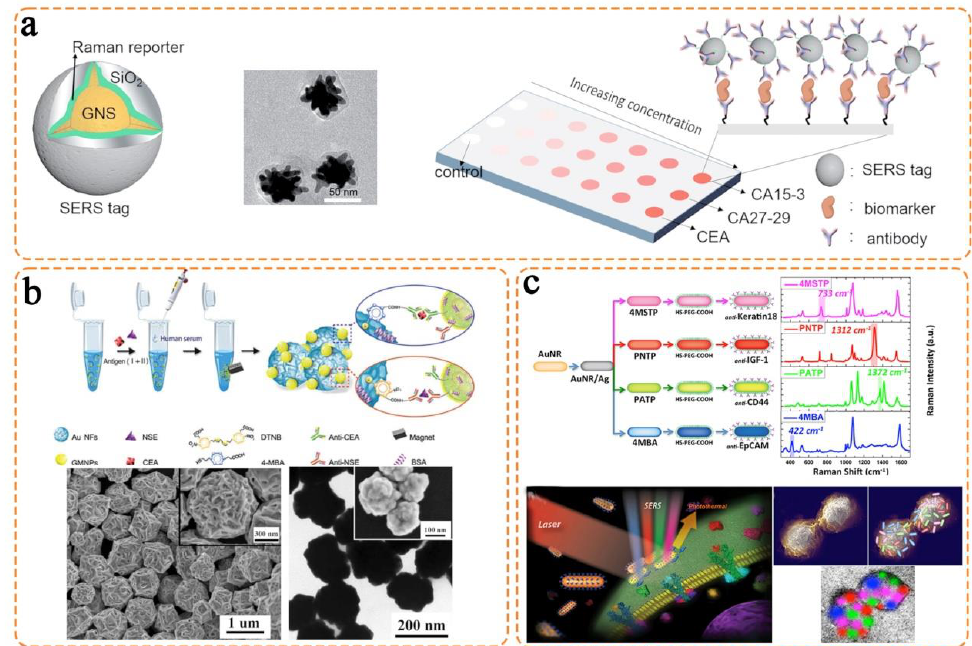
Figure 6. Anisotropic nanostructure-based SERS nanotags for parallel detection of multiple circulating biomarkers. ( a ) Gold nanostars as plasmonic nanostructures to detect three breast cancer antigens (i.e., CEA, CA27-29, and CA15-3). Reproduced with permission [51]. Copyright 2015, Royal Society of Chemistry. ( b ) Gold nanoflowers allowing the parallel and sensitive detection of two lung cancer-associated biomarkers (i.e., NSE and CEA) with the scanning electron microscope (SEM) and transmission electron microscope (TEM) images showing the morphology of gold nanoflowers. Reproduced with permission. Copyright 2016, Royal Society of Chemistry [52]. ( c ) Silver-gold nanorods promoting multi-color and multi-mode detection of biomarkers (i.e., Keratin18, IGF-1, CD44, and EpCAM) on breast cancer CTCs. Reproduced with permission [53]. Copyright 2014, Nature Publishing Group.